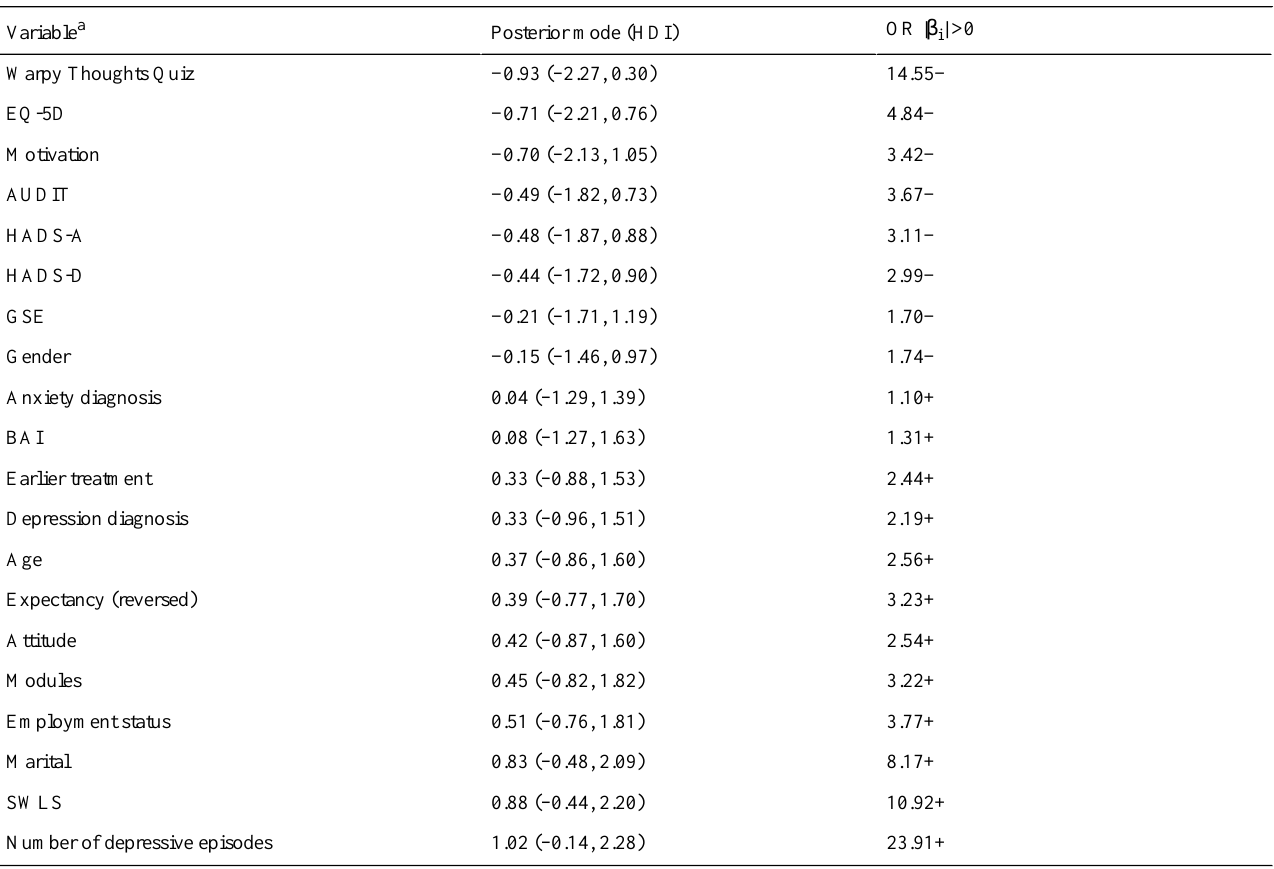
Table 3. Posterior mode, highest density interval (HDI), and odds ratios for the beta coefficients predicting probability of being a responder. The odds ratios indicate the probability that each covariate has a positive/negative impact relative to the probability of the opposite (+: positive effect; -: negative effect), but do not indicate the strength of this